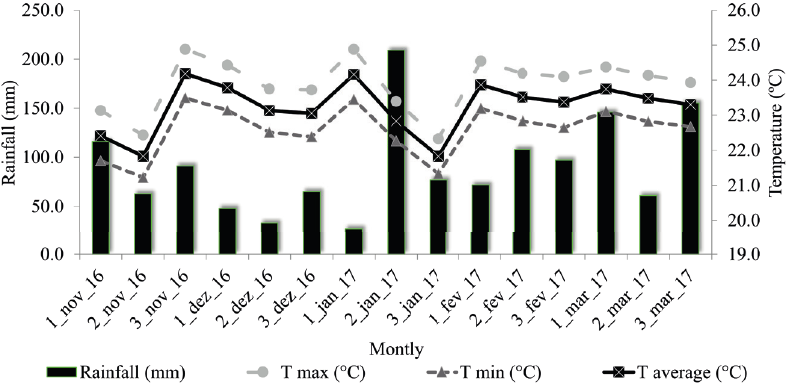
Figure 1. Rainfall (mm), maximum, minimum, and average temperature (°C) every ten days, during the soybean cultivation in the fi eld. Chapadão do Sul-MS, agricultural year